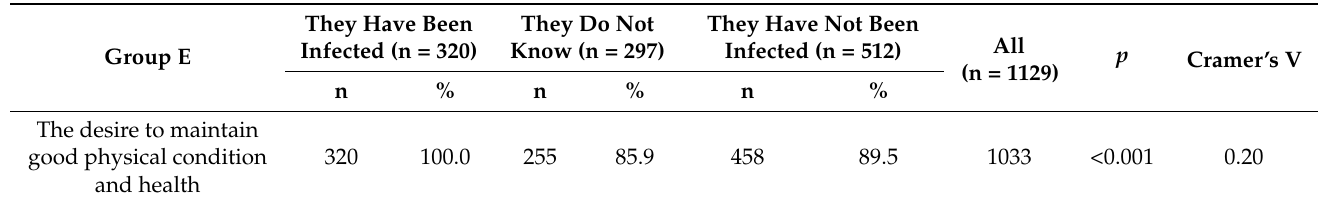
Table 6. Other motives versus COVID-19